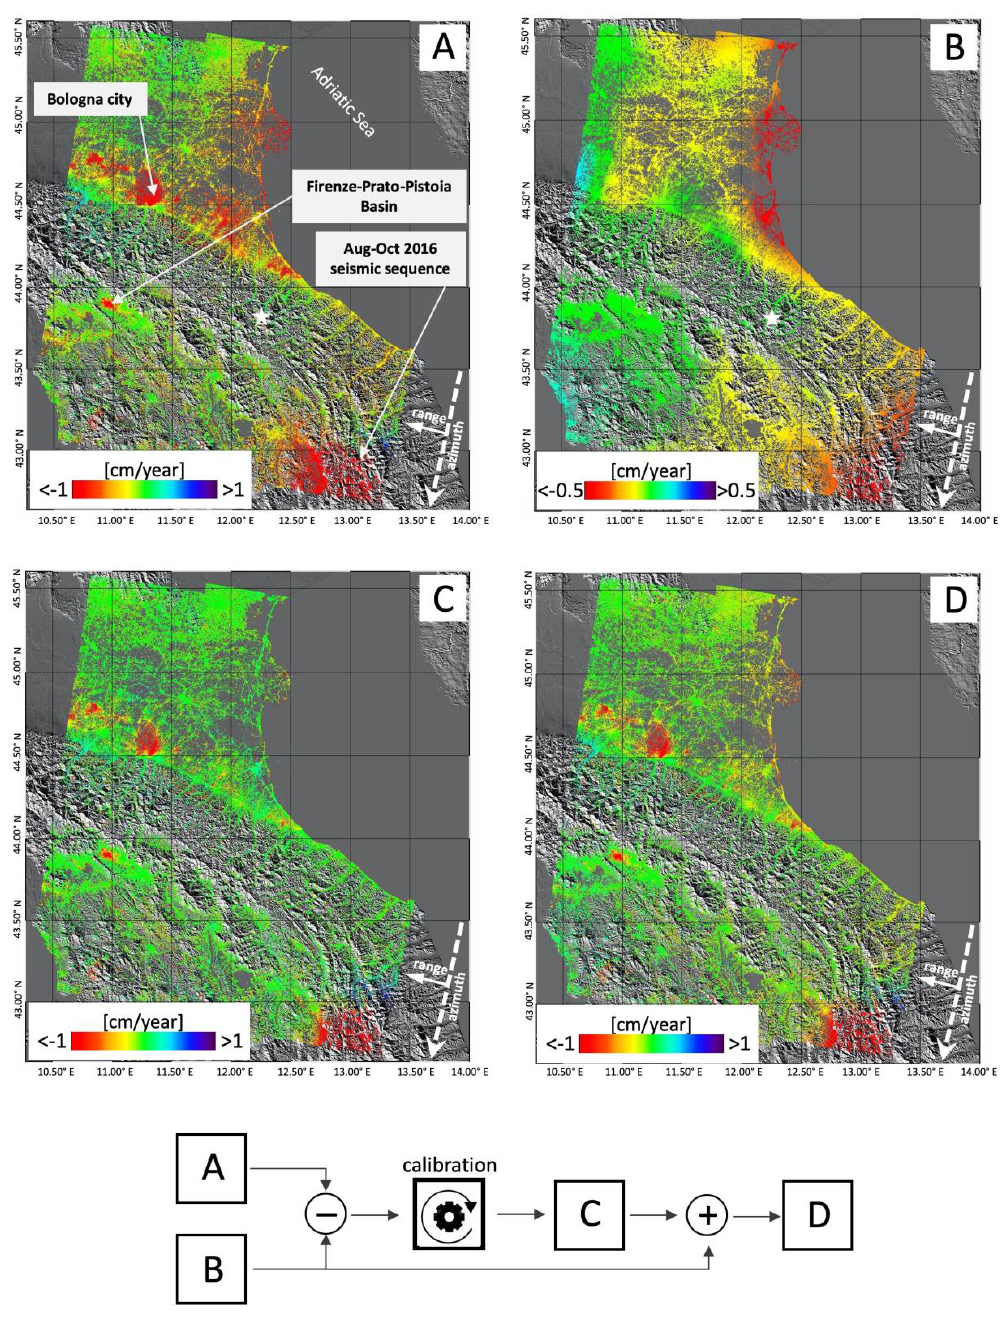
Figure 6. Pictorial example of the implemented DInSAR deformation results refinement procedure applied to an S-1 IWS frame relevant to a portion of the Central-Northern Italy. ( A ) Mean deformation velocity map following the straightforward application of the P-SBAS approach. ( B ) Mean deformation velocity map obtained by interpolating the data relevant to the GNSS stations selected following the lines of Section 3.1. ( C ) Mean deformation velocity map of the high spatial frequency component. ( D ) Mean deformation showing the velocity map of the overall signals. The white star in panels A and B identifies the reference pixel, while the white arrows in the lower right corners show the SAR sensor azimuth/range directions. At the bottom a block diagram of the implemented procedure is shown.